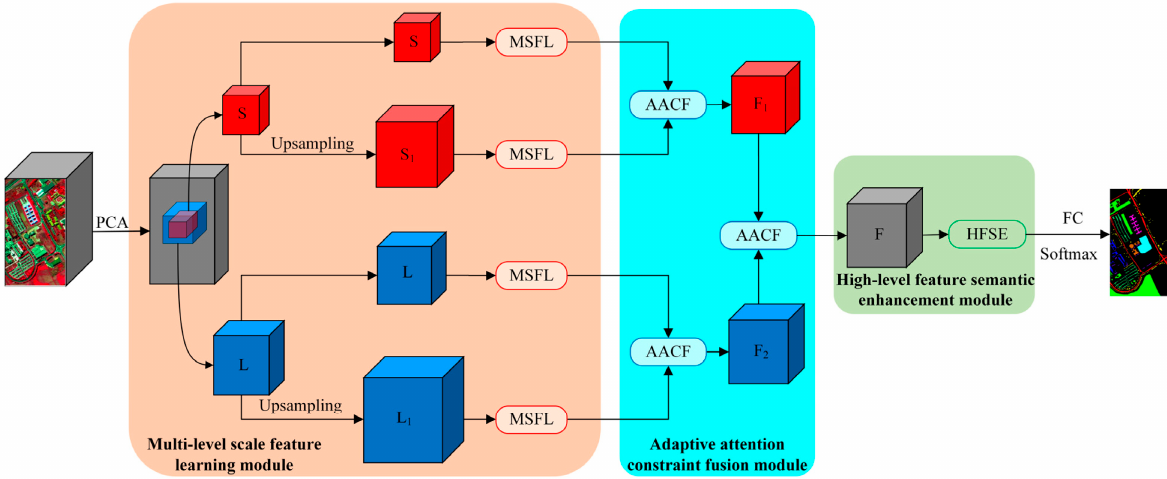
Figure 1. The structure of the proposed method. MSFL denotes the multiscale feature learning module, AACF denotes the adaptive attention constraint fusion module, and HFSE denotes the high ‐ level feature semantic enhancement module. After PCA dimension reduction, two different scales of pixel neighborhood are selected to form S and L; S and L are learned by the upper and lower parts of the network, and then fused by AACF.